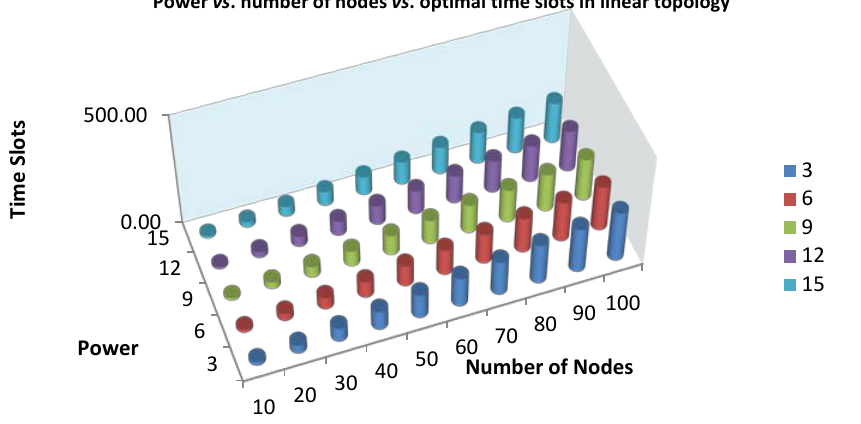
Figure 8. Power vs. the number of nodes vs. optimal time slots in a linear topology.